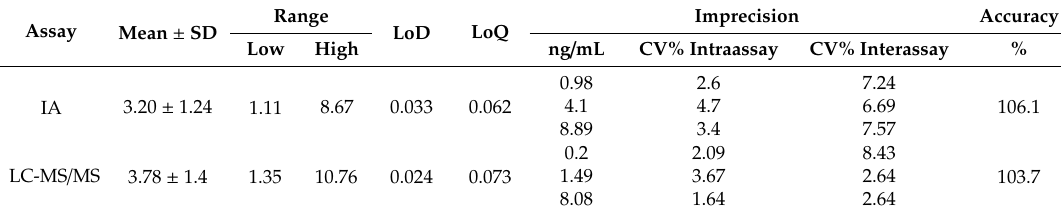
Table 2. Characteristics obtained in the evaluation of testosterone assay